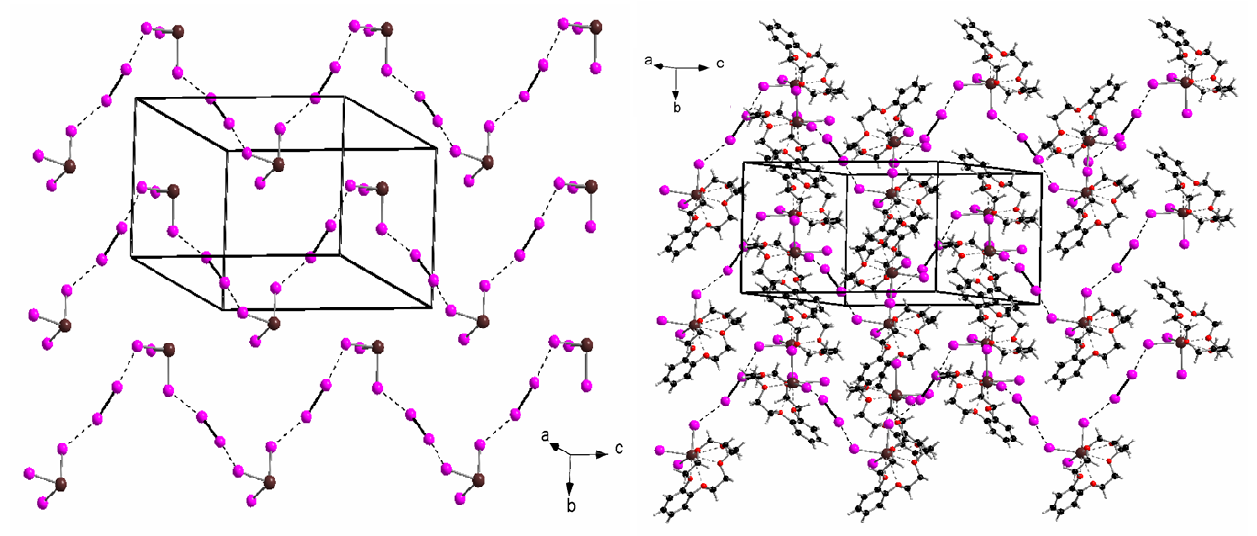
Figure 2. The arrangement of the zig-zag chains in (b15c5)BiI and with crown ether molecules (right)